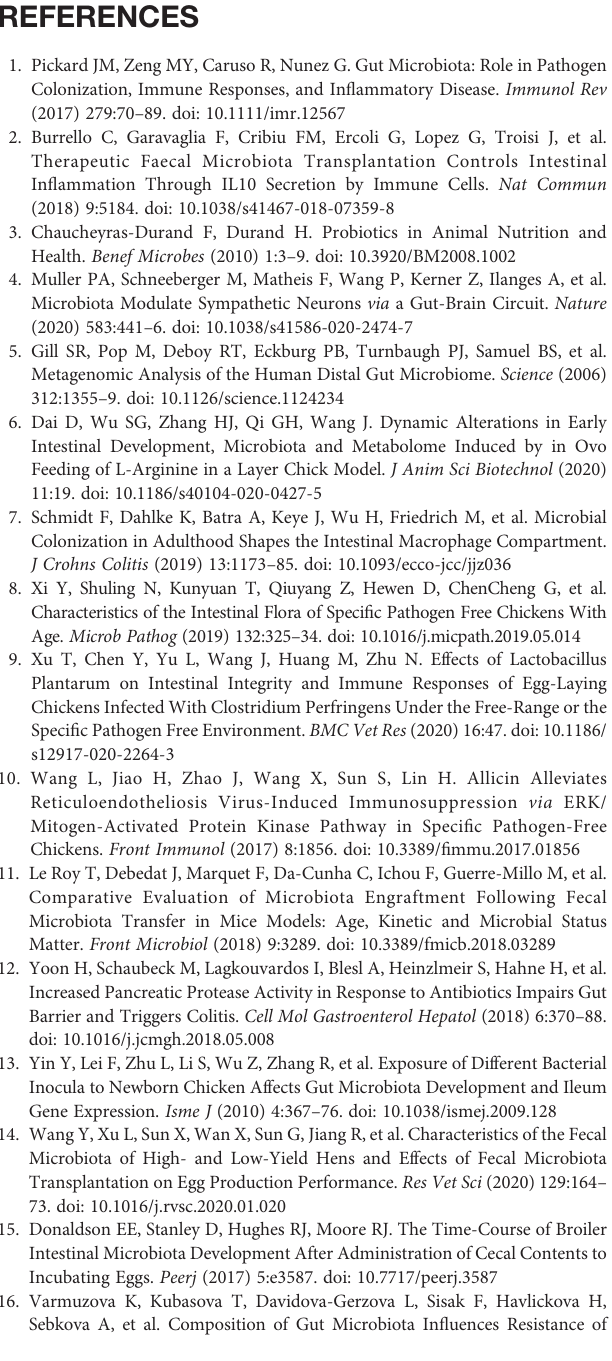
Supplementary Figure 7 | The pathway enrichment of differential metabolites based on KEGG between IBF birds and control. The results in the negative ion mode were arranged on the left, and the results in the positive ion mode were displayed on the other side, n=5. Supplementary Figure 8 | The pathway enrichment of differential metabolites based on KEGG between IBF-CTR birds and IBF-FMT. The results in the negative ion mode were arranged on the left, and the results in the positive ion mode were displayed on the other side, n=6.